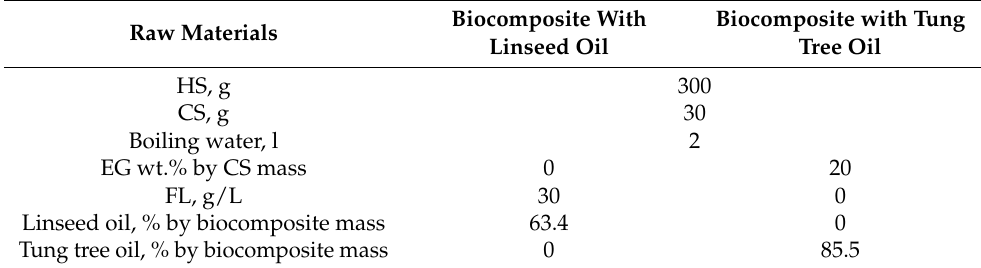
Table 1. Compositions of HS- and CS-based biocomposites. Raw Materials